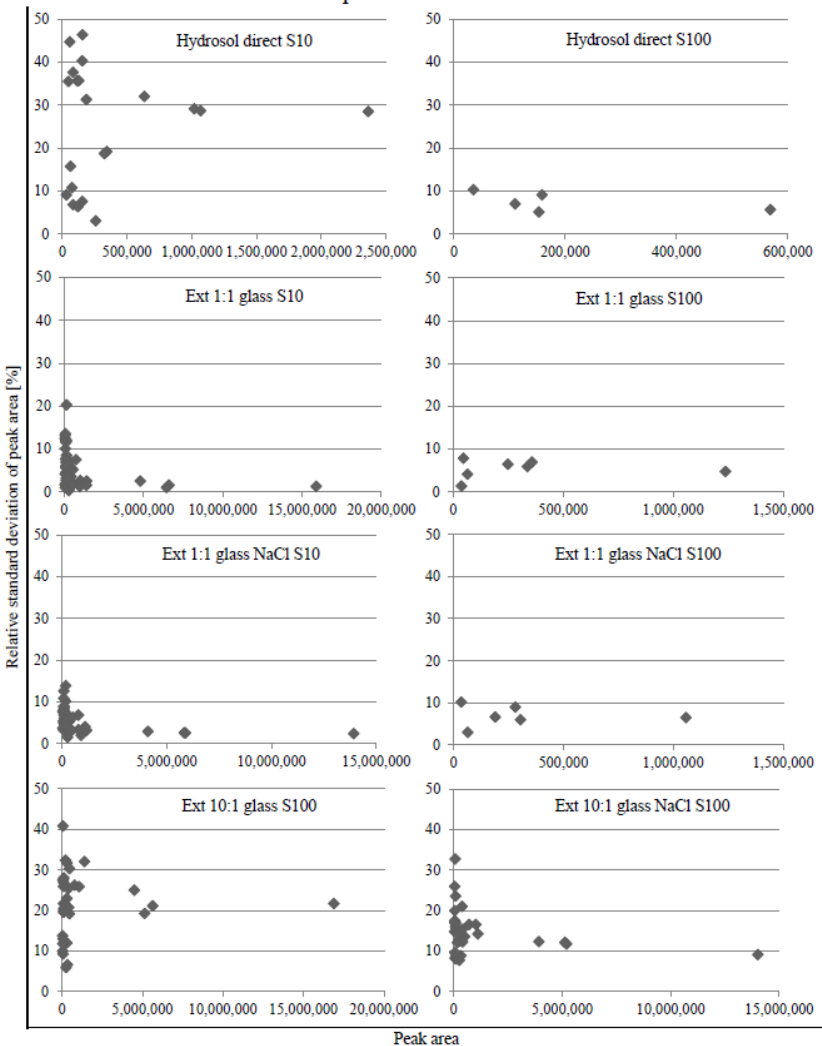
Figure 1. Relative standard deviation of peak areas (method used: Ext 1:1 glass—extraction vol:vol